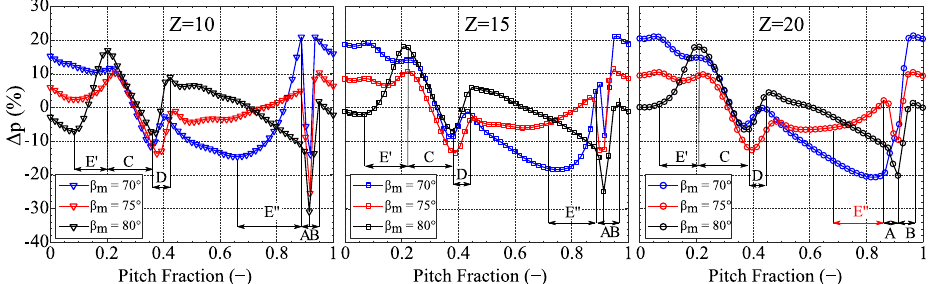
Figure 8. Mid-span pitch-wise static pressure distribution at rotor inlet radius expressed as a percent deviation with respect to mean value, grouped by vane count.